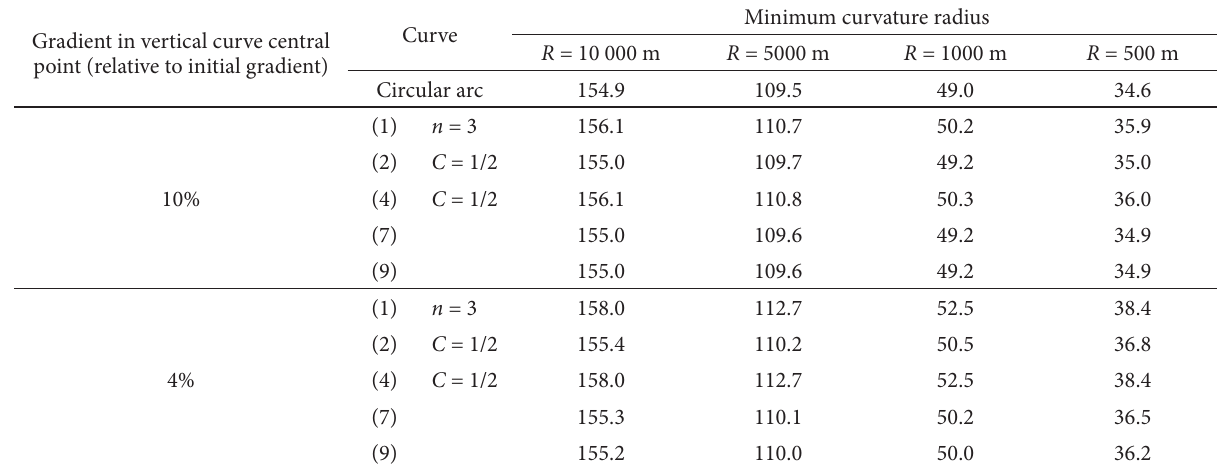
Table 3. Minimum sight distances, m in symmetric crest arcs characterised by variable curvature for selected radii R , m Minimum curvature Curve Gradient in vertical curve central point (relative to initial gradient)